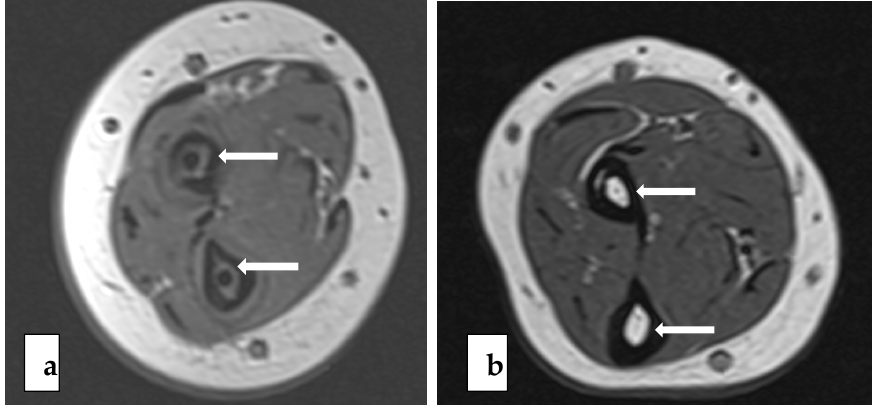
Figure 2. T1-weighted axial images showing low-signal biodegradable nails (white arrows) one month postoperatively ( a ) and faint nail residuals 6.5 years postoperatively ( b ).